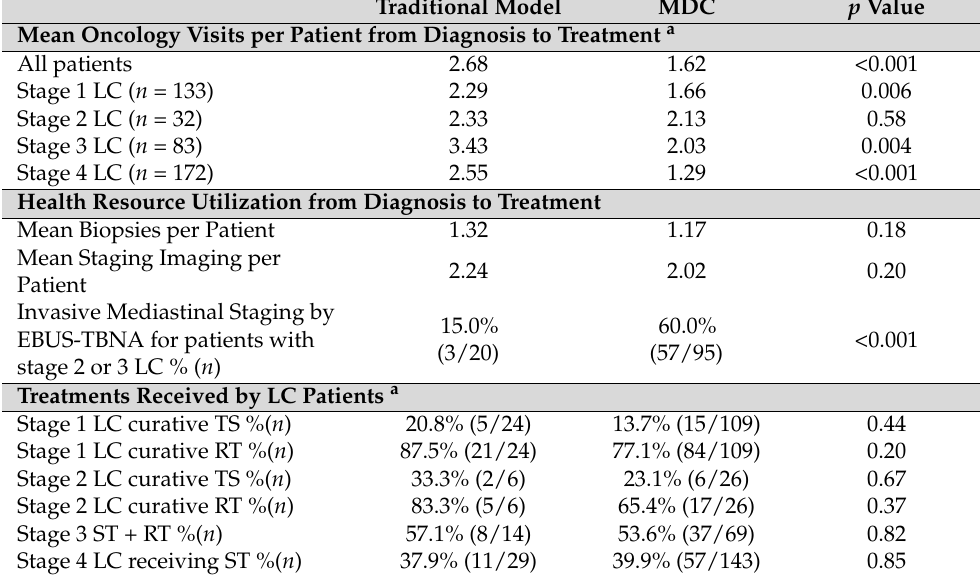
Table 2. Oncology visits and health resource utilization during the diagnosis to treatment time interval in the traditional and multidisciplinary clinic